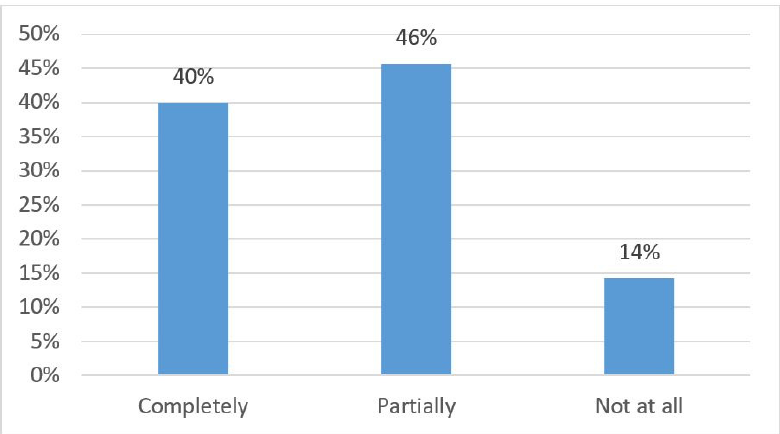
Figure 11. Respondents’ compliance with space reduction and integration of GMDSS equipment.